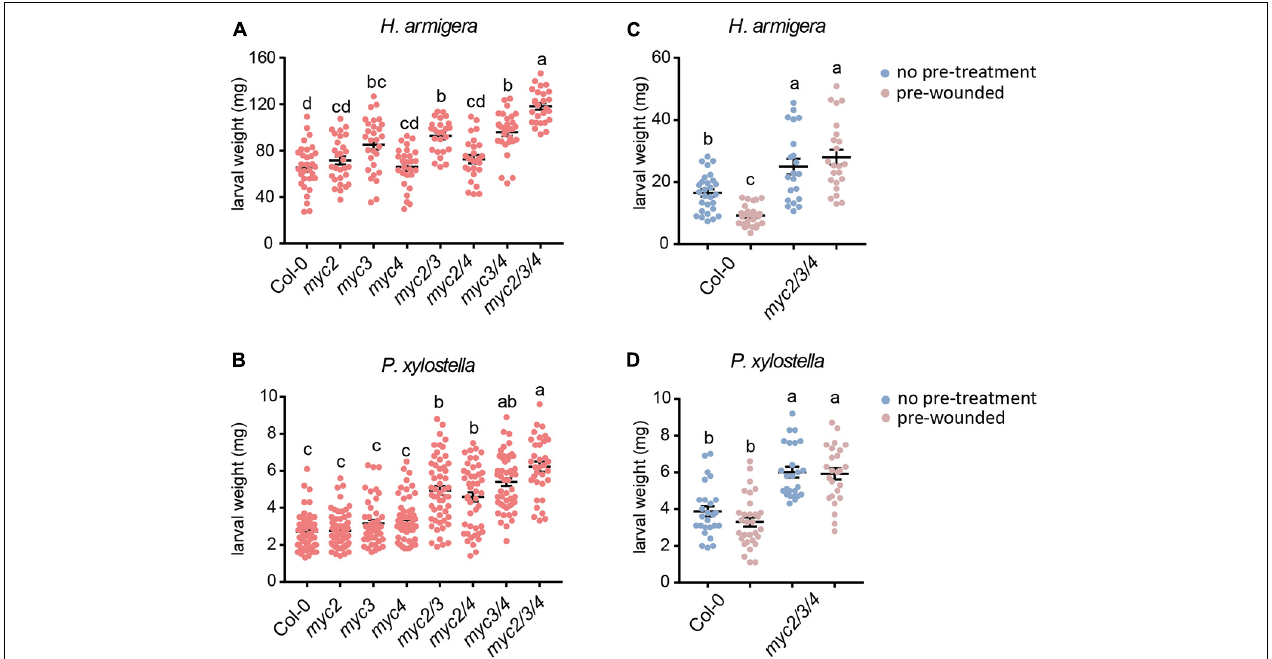
FIGURE 1 | Involvement of MYC2, MYC3, and MYC4 in plant resistance to insect. Helicoverpa armigera (A,C) and P. xylostella (B,D) larvae were fed with the indicated plants for 4 days. In panels (C,D) , the plants were wounded 1 day before being used for feeding. Data are means ± SEM ( n = 25–35) analyzed by one-way ANOVA and Tukey’s honest significant difference (HSD) test. Different letters indicate significant differences, P -value <